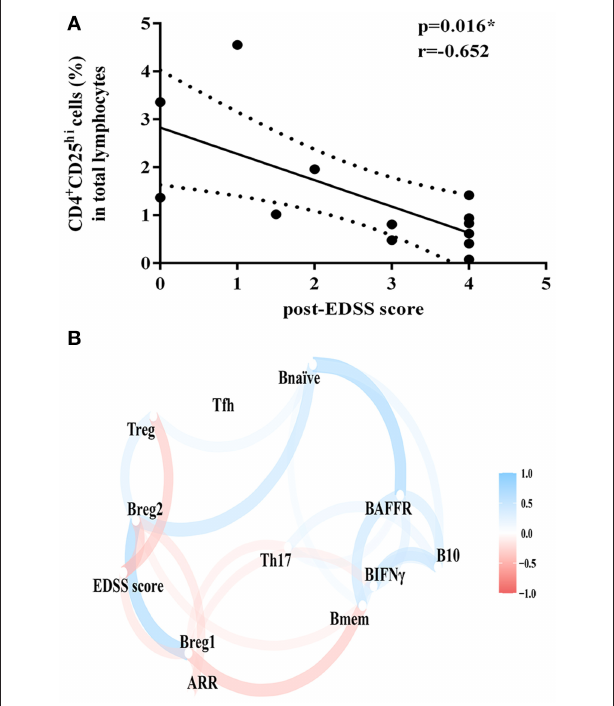
FIGURE 3 | Correlation analysis of clinical outcomes and proportion of lymphocyte subsets. (A) Correlation of EDSS score after TAC therapy and the proportion of CD4 + CD25 hi cell subsets. (B) Correlation and clustering analysis of all lymphocyte subsets and clinical outcomes during TAC therapy. Bmem, CD19 + CD27 + memory B cell; Bnaïve, CD19 + CD27 + naïve B cell; Breg1, CD19 + CD24 hi CD38 hi regulatory B cell; Breg2, CD19 + CD5 + CD1d hi regulatory B cell; BAFFR, CD19 + BAFFR + B cell; Tfh, CD4 + CXCR5 + ICOS + follicular helper T cell; Treg, CD4 + CD25 hi regulatory T cell; Th17, IL-17 expressing CD4 + T cell; BIFN γ , IFN- γ expressing CD19 + B cell; B10, IL-10 expressing CD19 + B cell; EDSS, Expanded Disability Status Scale; ARR, annualized relapse rate. Variables that were more highly correlated appeared closer together and were connected by stronger paths. Paths were also colored by their sign (blue for positive and red for negative). The proximity of the points was determined through multidimensional